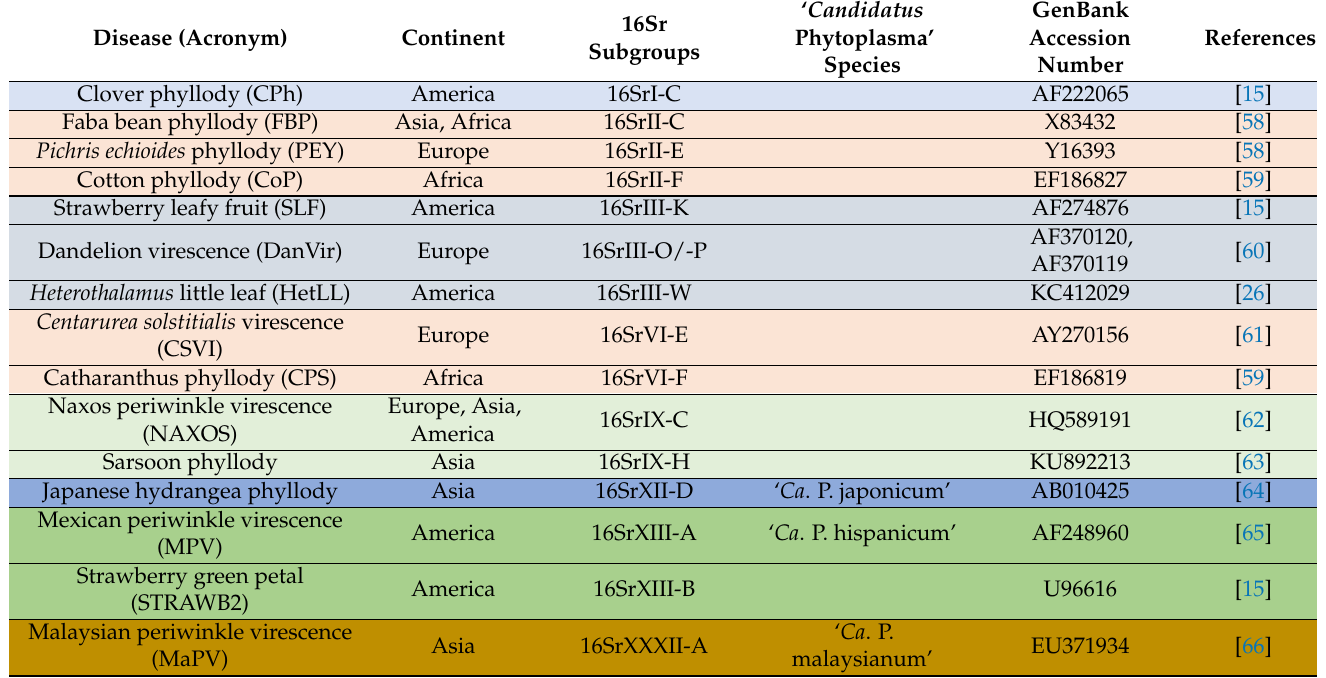
Table 3. Molecular diversity and geographic distribution of selected phytoplasmas belonging to different ribosomal groups/‘ Candidatus Phytoplasma’ species (marked by different color) and associated with phyllody and virescence symptoms.